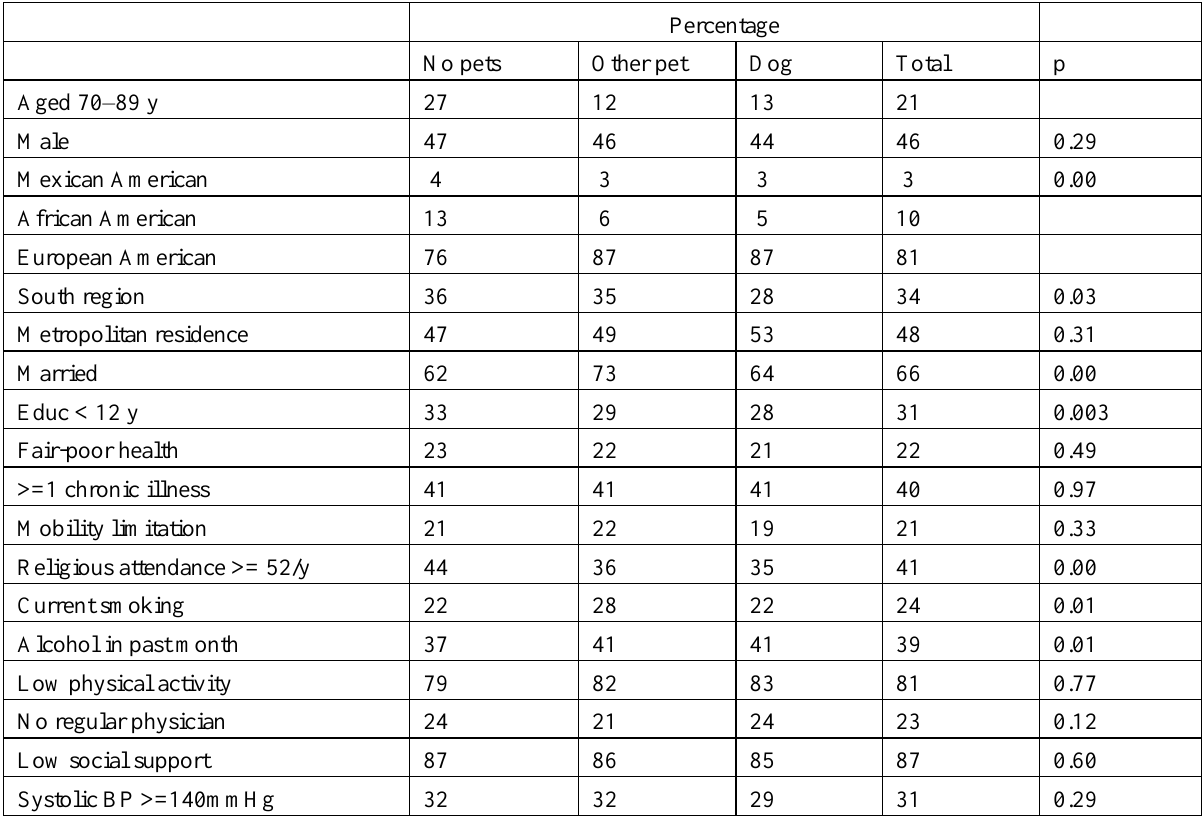
Table 2. Age-adjusted prevalence (%) of selected characteristics and living with companion animals in persons aged 40+y: NHANES